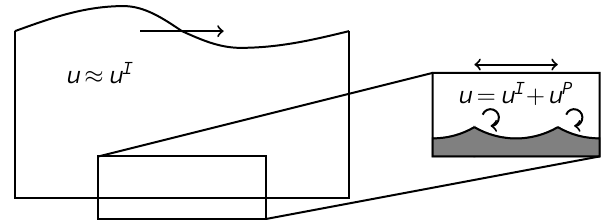
Figure 1. Schematic of hybrid model of vortex ripples and bound- ary layer flow. In most of the domain, the wave-induced flow can be (and is) considered inviscid (left), but above rippled beds, turbulent vortices are the dominant cause of momentum transfer (right), pro- duced by the mostly oscillatory flow. A fully viscous/turbulent flow is modeled in this region using